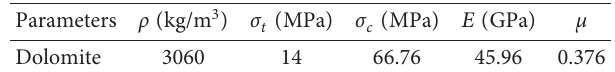
Table 4: Parameters of the rock